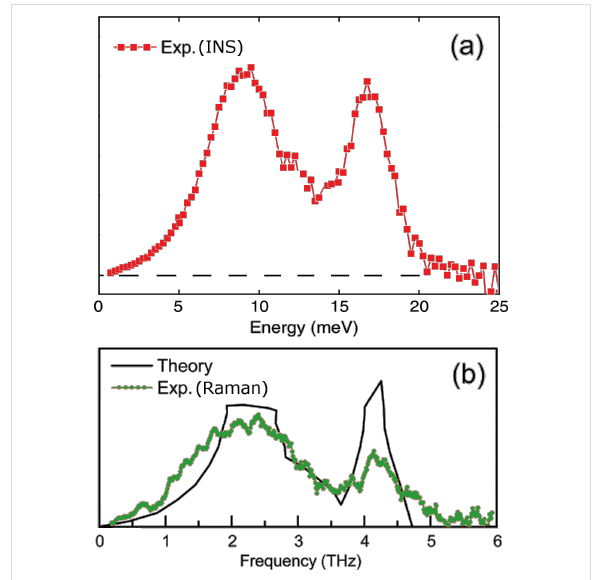
Figure 2: Vibrational density of states of gold as extracted from (a) inelastic neutron scattering on thick foils [2], (b) plasmon reso- nance Raman scattering on nanocrystals [3] (green dots) and recon- structed from force constants fitted to inelastic neutron scattering data from massive single crystals [4] (continuous black line). Adapted from Figure 2 of Muñoz et al. [2] and Figure 5a of Bayle and co-workers